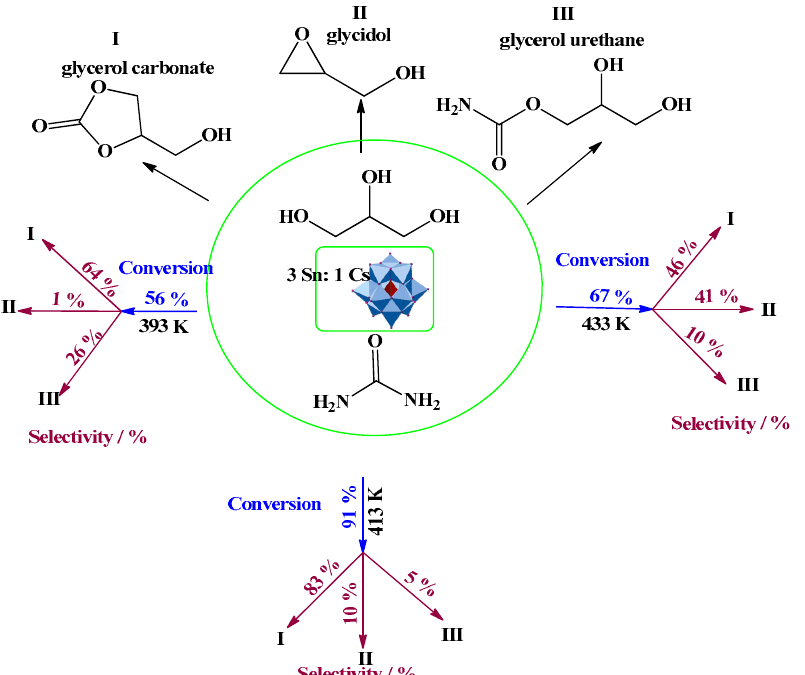
Figure 34. Impact of temperature on the conversion and selectivity of Sn/Cs 3 PW 12 O 40 − catalyzed glycerol carbonation with urea (adapted from ref. [75]).